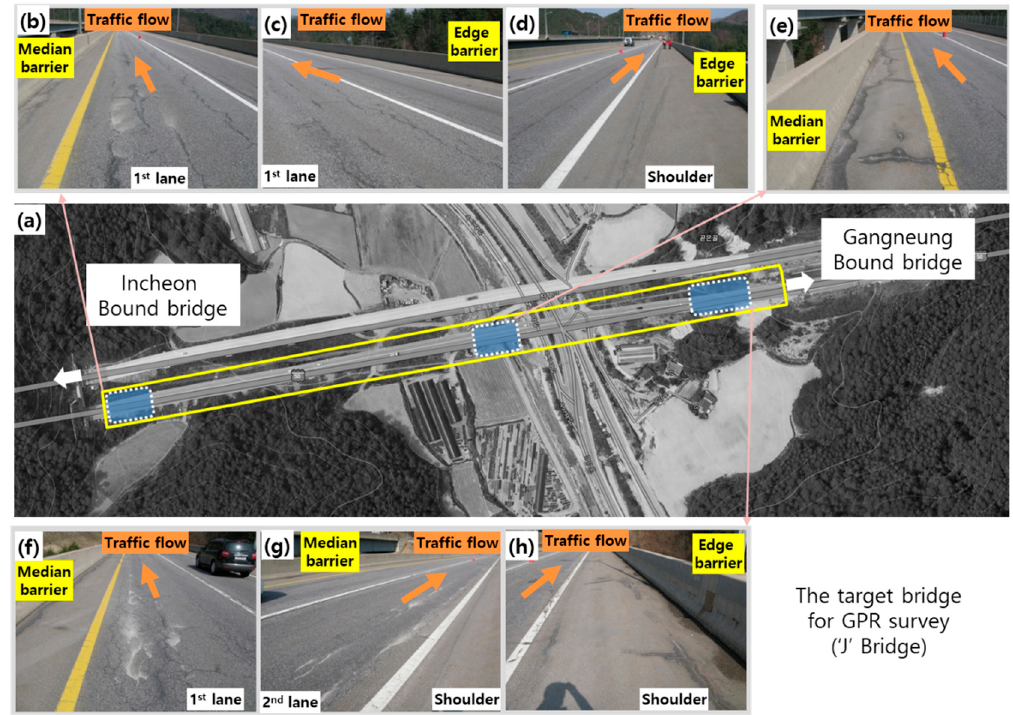
Figure 9. Overview of the target bridge (“J” bridge) for validation of the proposed GPR signal interpretation): ( a ) a satellite map of the target “J” bridge, ( b – h ) pictures presenting deterioration conditions on the surface of bridge decks in the target “J” bridge.